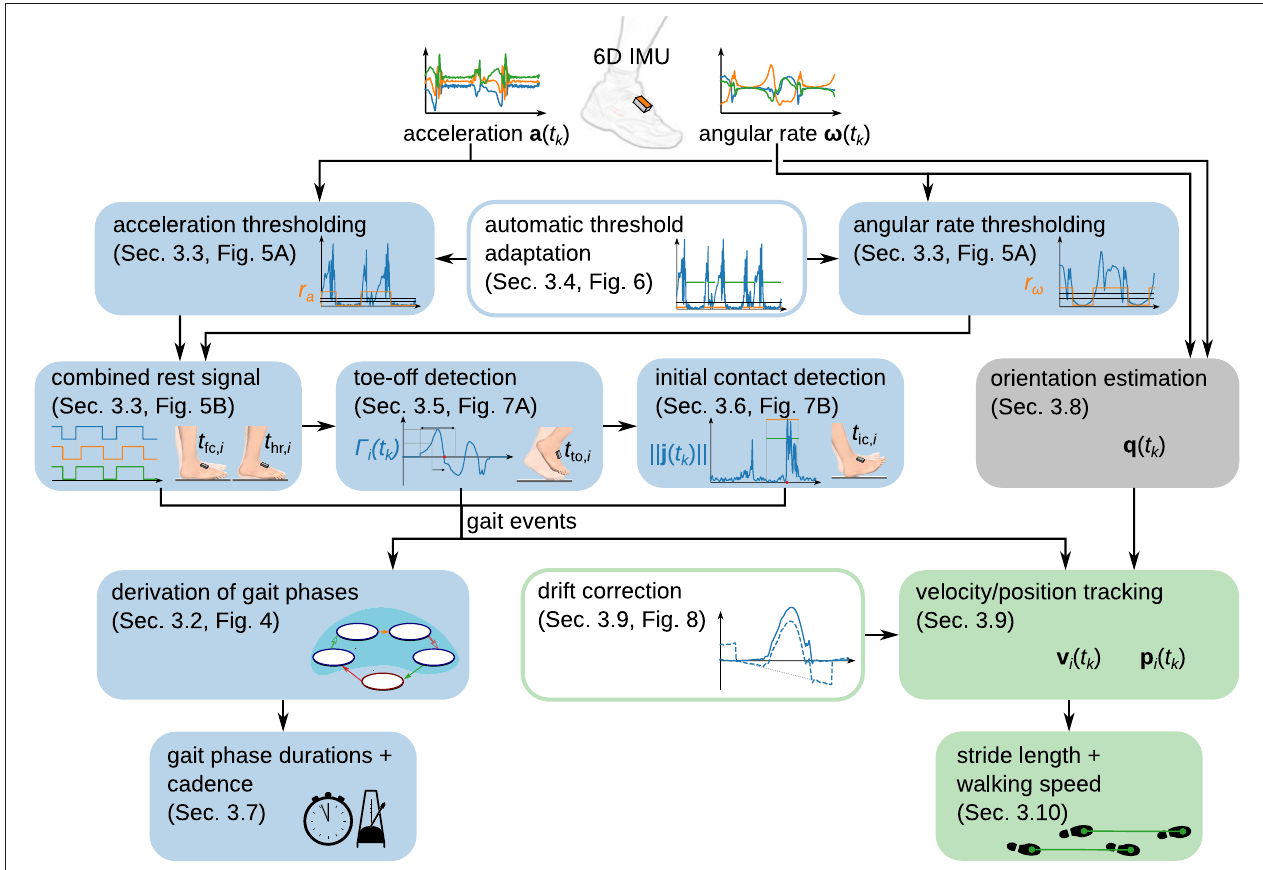
FIGURE 2 | Overview of the proposed modular set of methods to determine spatiotemporal gait parameters from foot-worn IMUs. While gait phase durations and cadence are determined from gait events, stride length and walking speed are derived from a position trajectory obtained via piecewise strapdown integration of the